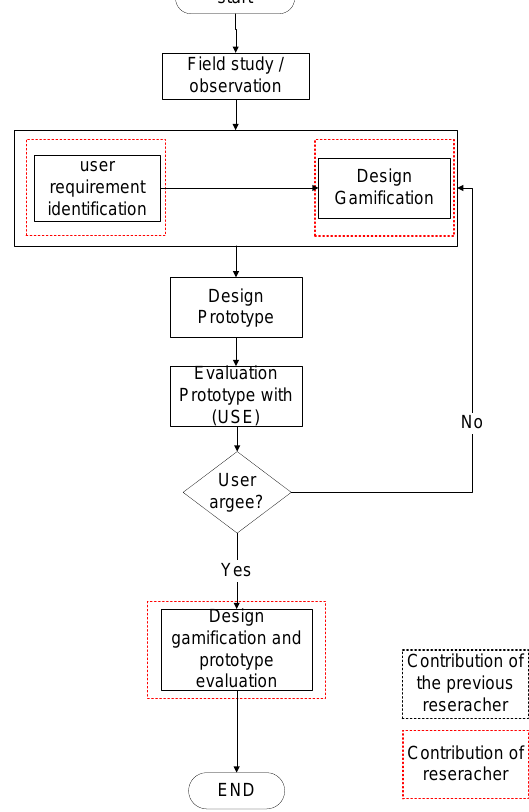
Fig. 2. Research flowchart